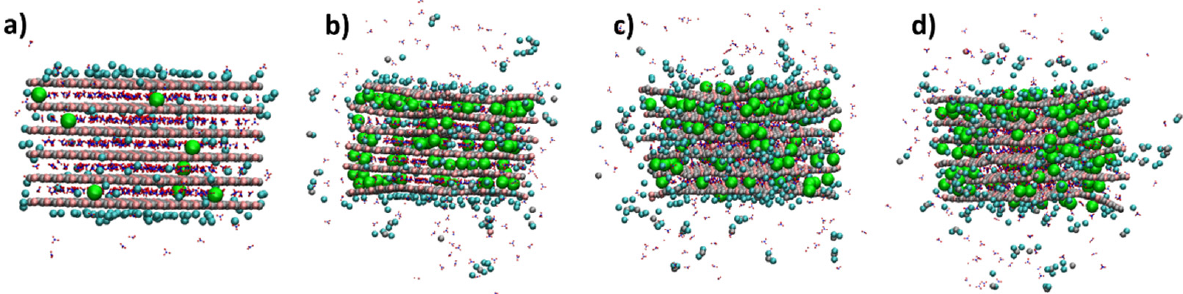
Figure 2. Snapshots of the different stages of the MD simulation for LDH-NO 3 . After the NVT equilibration (( a ), 0 ns), NpT equilibration (( b ), 10 ns), and the two NpT production runs of 50 ns (( c ), 60 ns and ( d ), 110 ns). The chemical elements’ color code is ochre for Al, silver for Zn, red for O, and white for H. Cl inside the LDH is in green, while cyan was used for external Cl (surface Cl) at less than 5 Å of Al and Zn. The nitrates are represented by dots and sticks with blue for N and red for O. Magnified versions of the panels presented in this Figure are provided in the SI (Figure